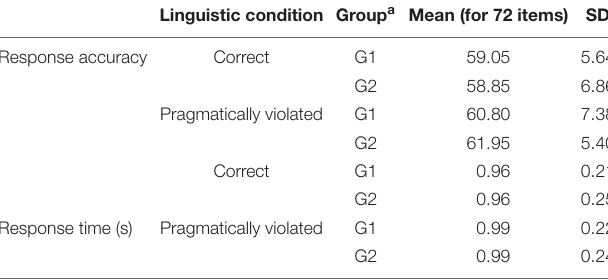
TABLE 4 | Descriptive statistics of response accuracy scores and response times for G1and